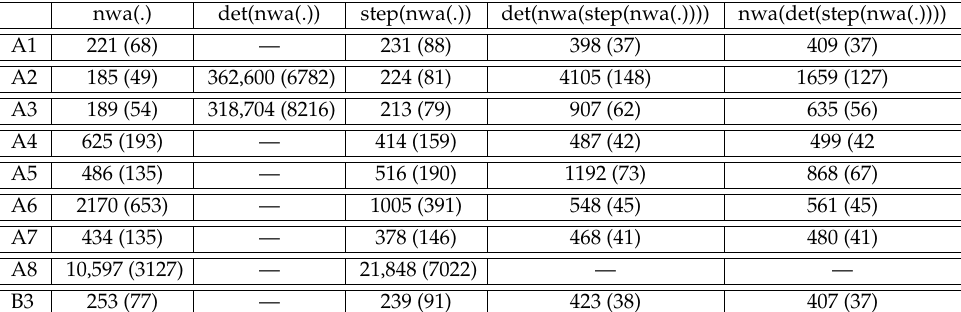
Figure 12. The size (#states) of the NWAs for the benchmark NREs and the automata derived